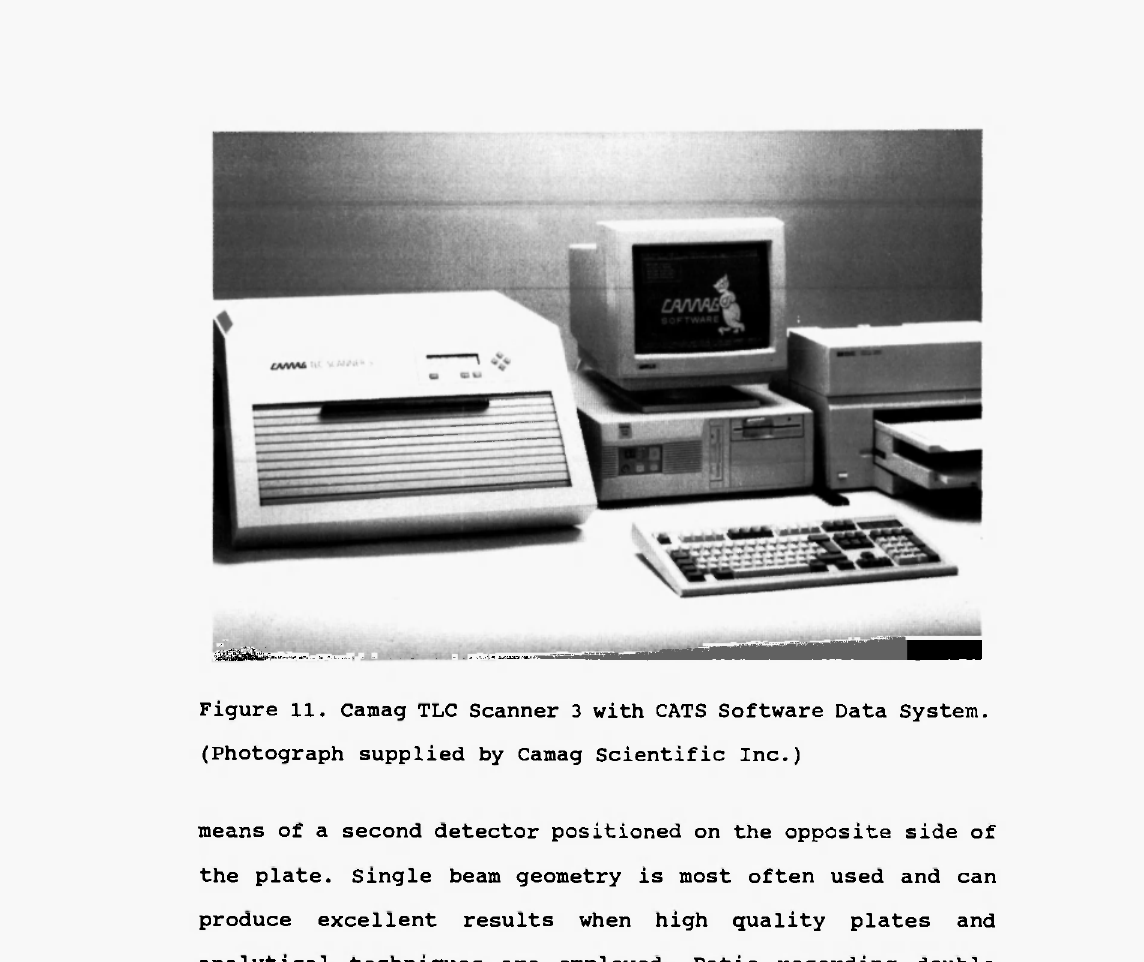
Figure 11. Camag TLC Scanner 3 with CATS Software Data